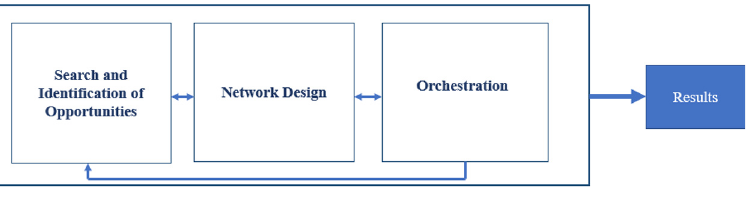
Figure 2. Proposed model for orchestrating innovation